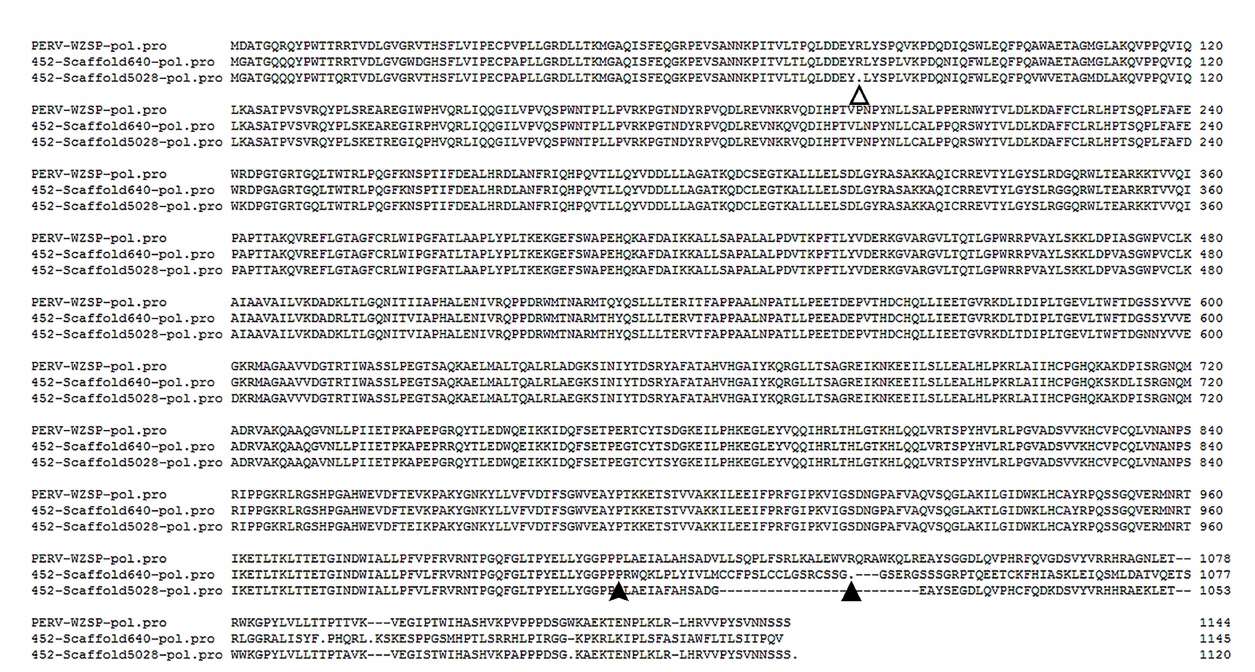
FIGURE 2 | Alignment of the deduced amino acid sequences of the PERV pol from Scaffold640 and Scaffold5028 with that of PERV-WZSP isolate (GenBank accession number: EF133960.1). The fi lled arrowhead indicates the position of a two base-pair (CC) addition in the sequence of Scaffold640, which results in a frameshift mutation and premature termination at peptide position 1038 (indicated by the fi lled triangle). The un fi lled triangle indicates an A>T mutation in the sequence of Scaffold5028, which leads to a premature stop codon and resulted in a protein sequence truncated to 78 amino